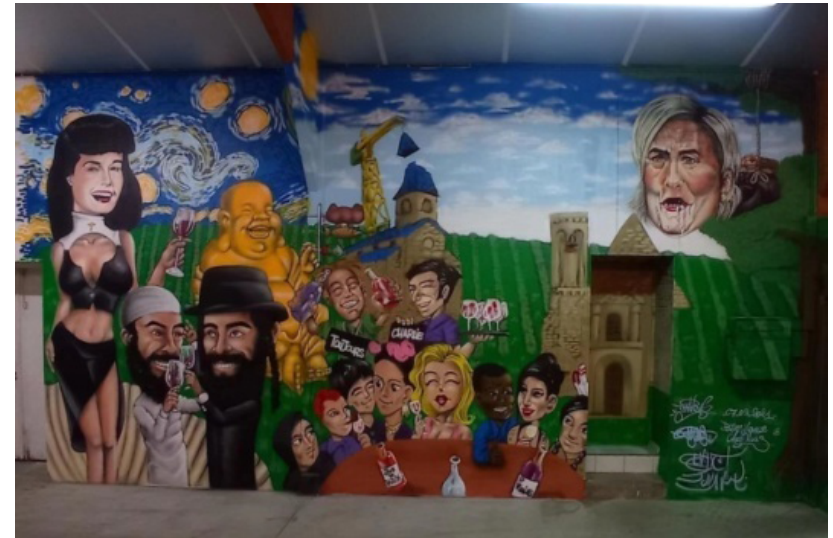
Figure 3. The collaborative mural by Tennch Tcha, The Jamet brothers, Alexandra Bombled Genneteau and Tchuj Tcha; reproduced courtesy of Tennch